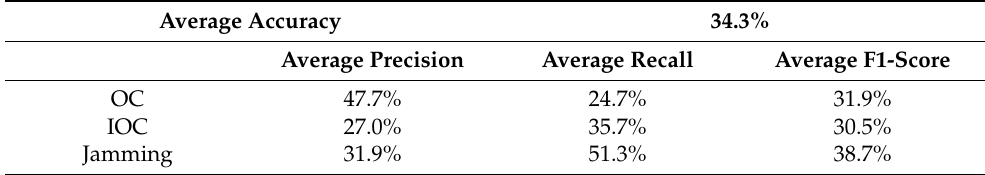
Table 11. TSF Multivariate Performance.